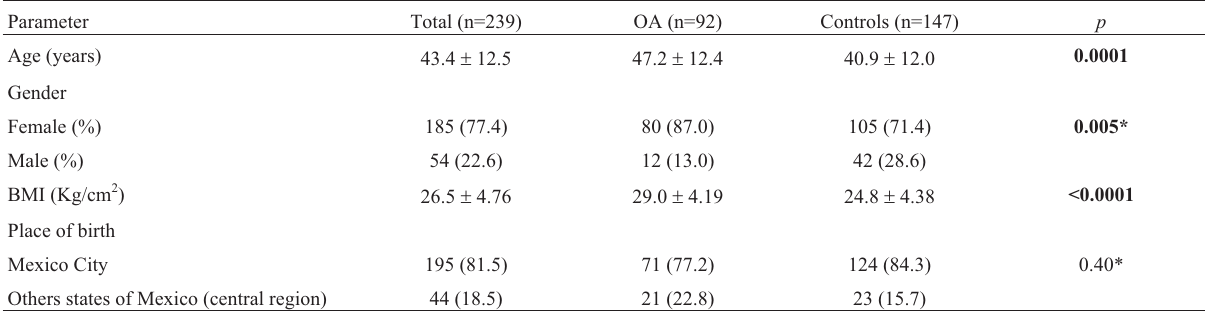
Table 2 - Characteristics of the study